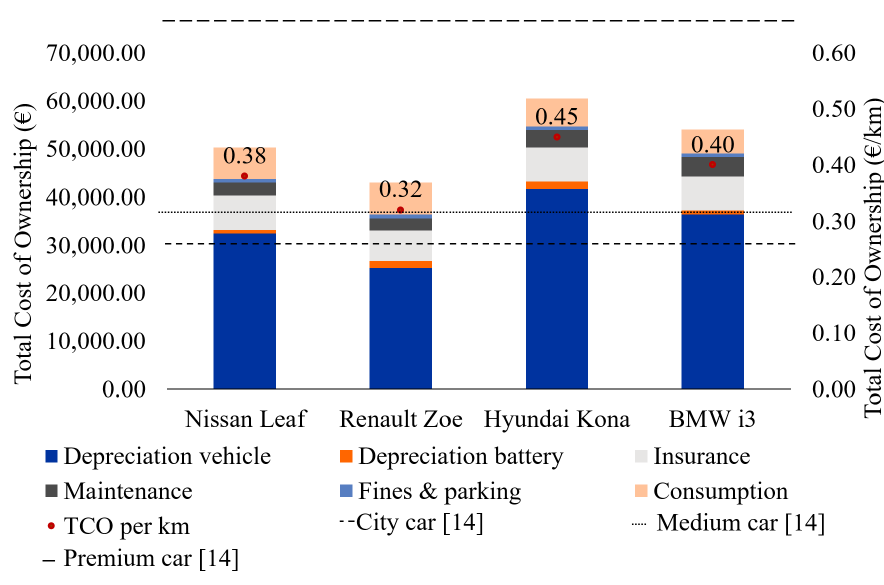
Figure 5. Standard TCO in a semi-public charging case (source: own compilation).